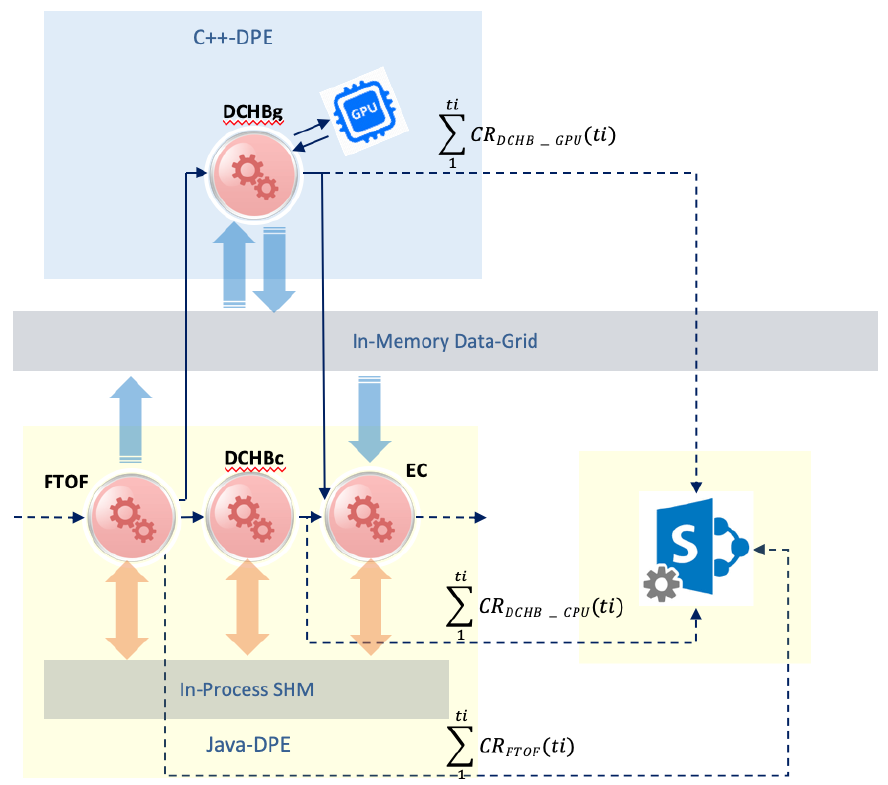
Fig. 4. CLAS12 heterogeneous dataflow